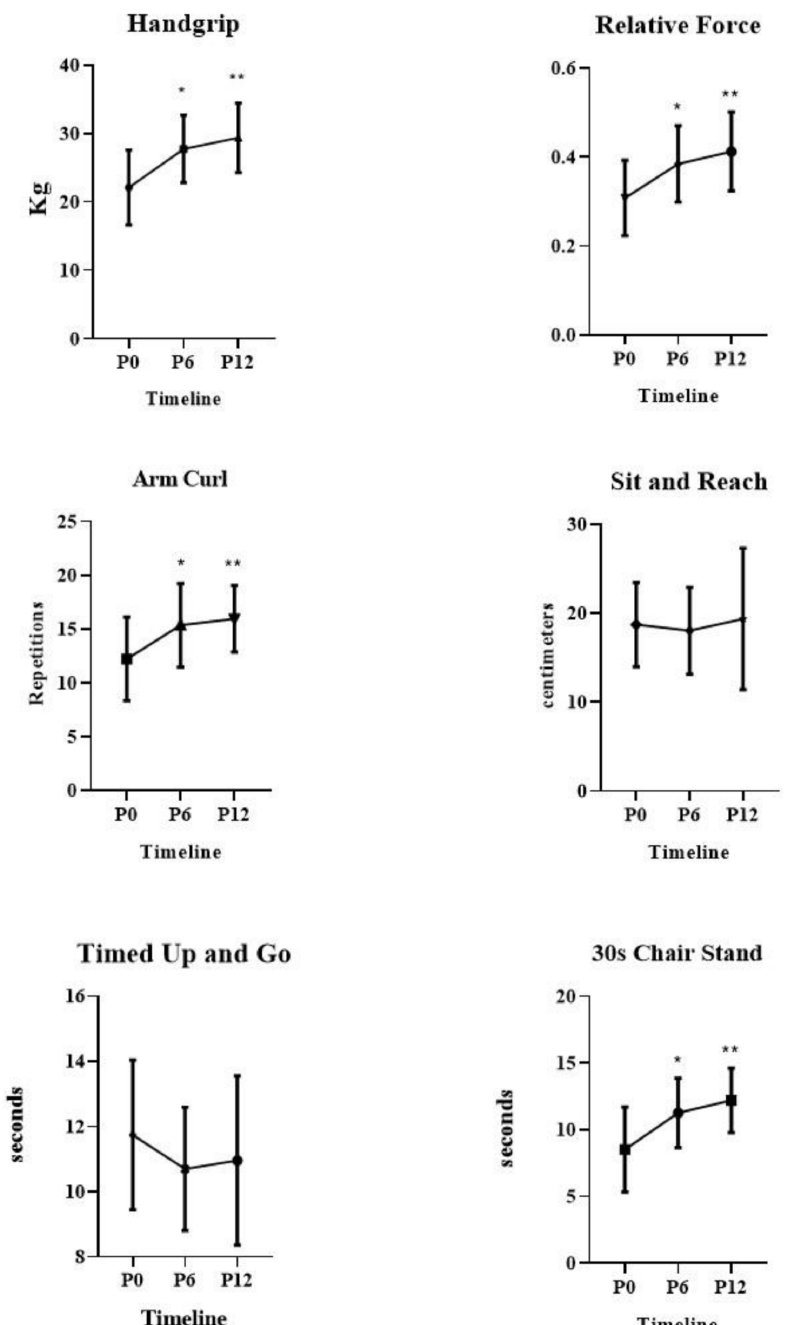
Figure 3. Physical Fitness results over 12-months of Vitamin D supplementation for elderly women. * Differences between P0 vs. P6, p = 0.0001, ** differences between P0 vs. P12, p = 0.0001.